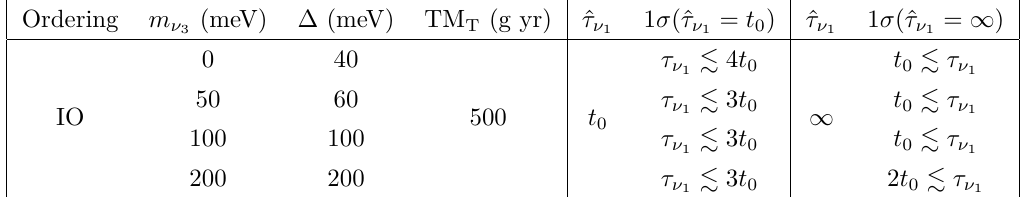
at 1 σ confidence level for ν 1